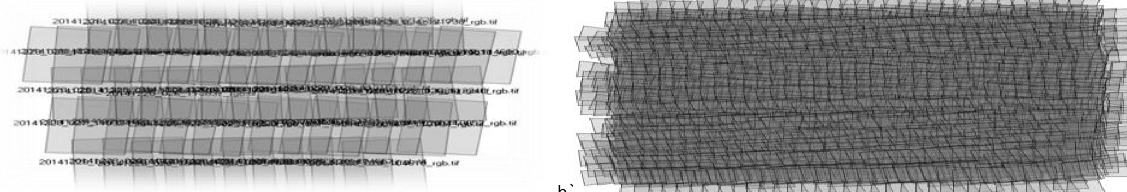
a) b) Figure 3: A footprint comparison - over the same area and with the same GSD - among a traditional nadir flight (a - ca 60 images) and an oblique flight coverage (b - ca 700 images) which requires more strips and thus more flying